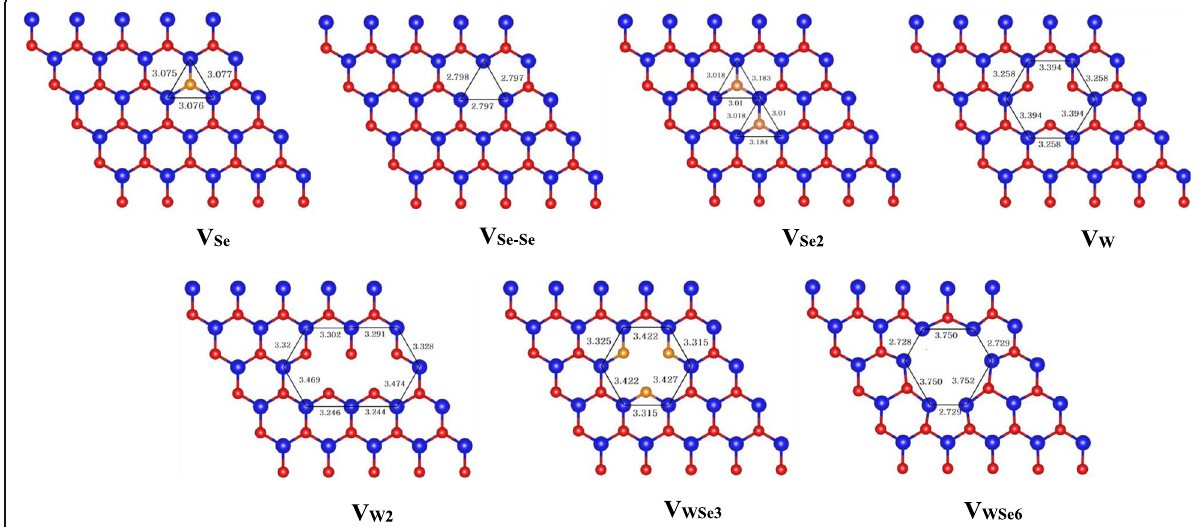
Fig. 2 The optimized atomic structures of monolayer WSe 2 with V Se , V Se-Se , V Se2 , V W , V W2 , V WSe3 , and V WSe6 vacancies. The blue, red, and tangerine balls represent W and Se atoms on the top and bottom layer,